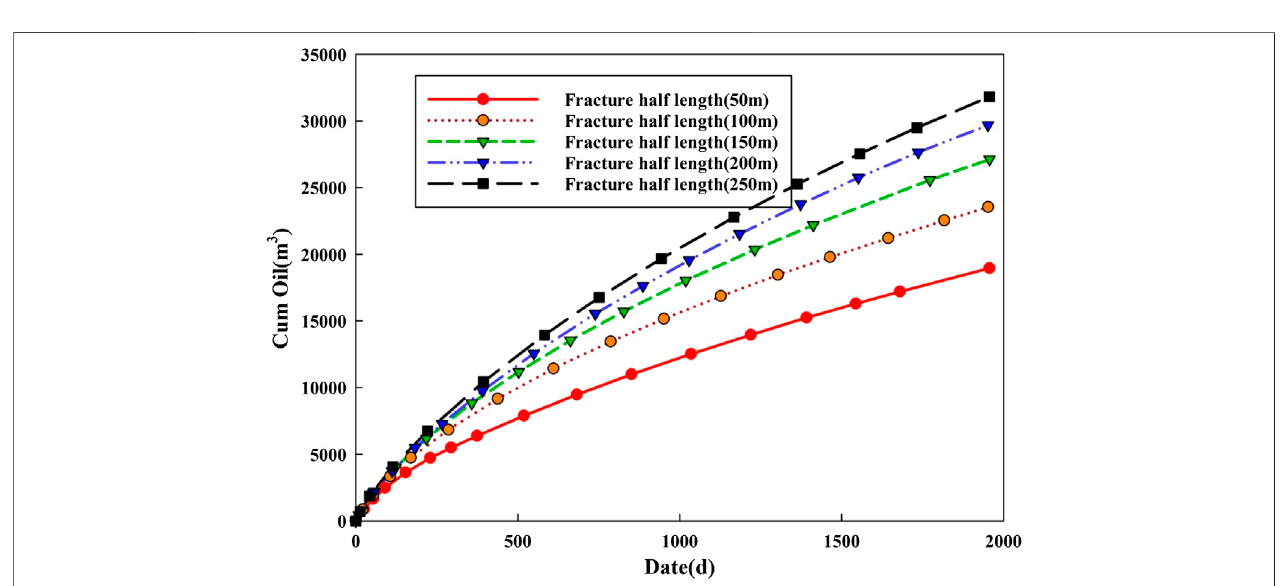
FIGURE 12 | Cumulative oil production curve of different fracture